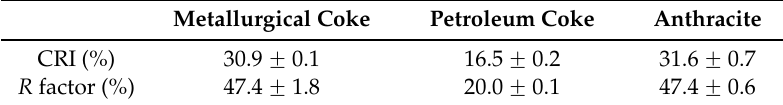
Table 9. Reactivity results of commercial reducing agents (50 g and 1375 mL ¨ min ´ 1 CO 2 ).